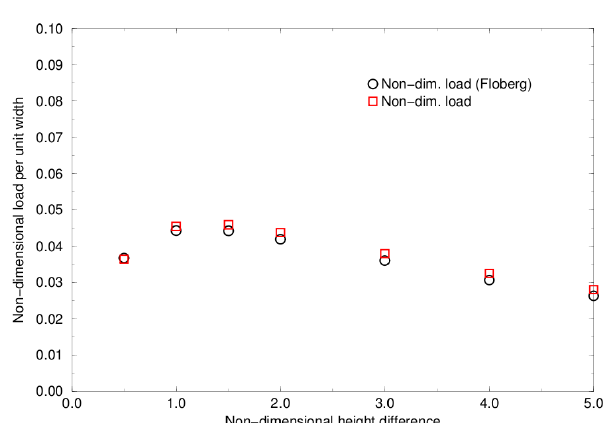
Figure 12: Non-dimensional load per unit width for sector-shaped tilting pad thrust bear- ing according to table 32.3 in (Floberg, 1969). Simulations, and calculations from (Floberg, 1969).